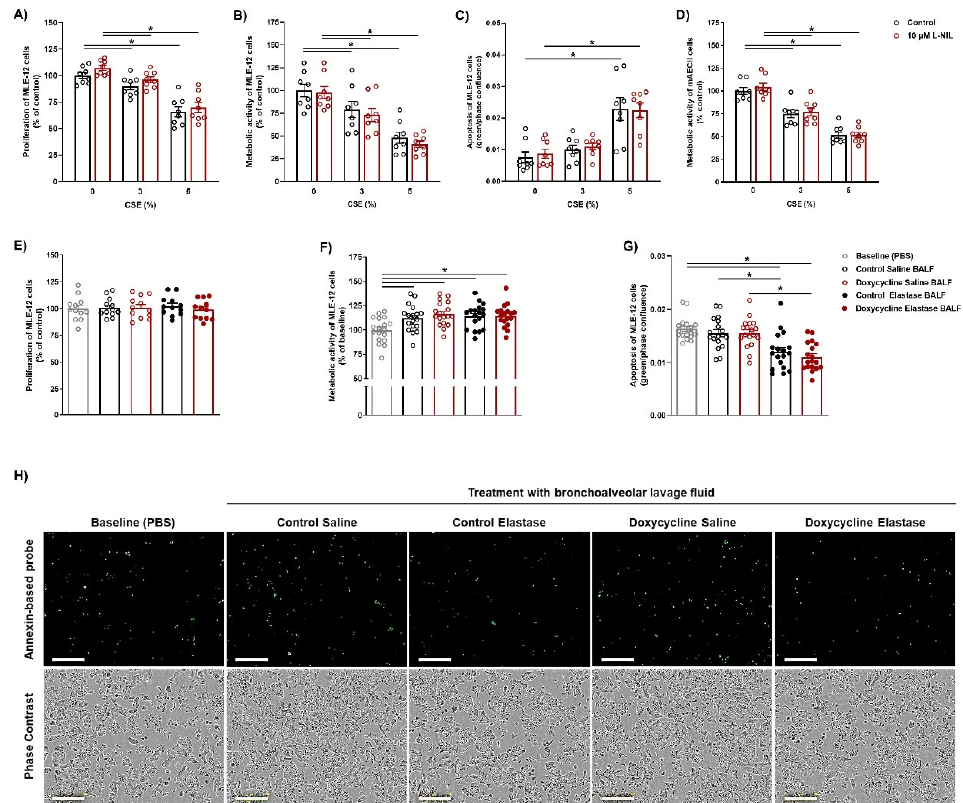
Figure 6. Bronchoalveolar lavage fluid from elastase-treated mice decreases apoptosis of mouse lung epithelial (MLE-12) cell-line in vitro . MLE-12 cells were treated with cigarette smoke extract (CSE) for 6 h, and then left for an additional 16 h in the presence or absence of L-NIL. ( A ) Proliferation of MLE-12 cells during the 16 h observation period assessed using the BrdU incorporation assay and standardized to control ( n = 8). ( B ) Metabolic activity of MLE-12 cells assessed after the 16 h observation period using the alamarBlue assay ( n = 8). ( C ) Apoptosis of MLE- 12 cells after the 16 h observation period given as the confluence of cells labeled with Annexin XII- based polarity-sensitive probe, standardized to total cell confluence ( n = 8). ( D ) Metabolic activity of primary murine alveolar epithelial type 2 cells (AECII) assessed using alamarBlue assay during the 16 h observation period ( n = 8). ( E – H ) MLE-12 cells were treated with 10% of either PBS (control) or bronchoalveolar lavage fluid (BALF) from saline- or elastase-treated iNos CCSP rtTA2 s -M2 LC1 mice, fed either with normal (control) or doxycycline-containing chow as above, taken after the 12- week observation period. ( E ) Proliferation of MLE-12 cells during 24 h of treatment, assessed using the BrdU incorporation assay and standardized to control ( n = 12). ( F ) Metabolic activity of MLE-12 cells after 24 h of treatment, measured using the alamarBlue assay and standardized to control ( n =